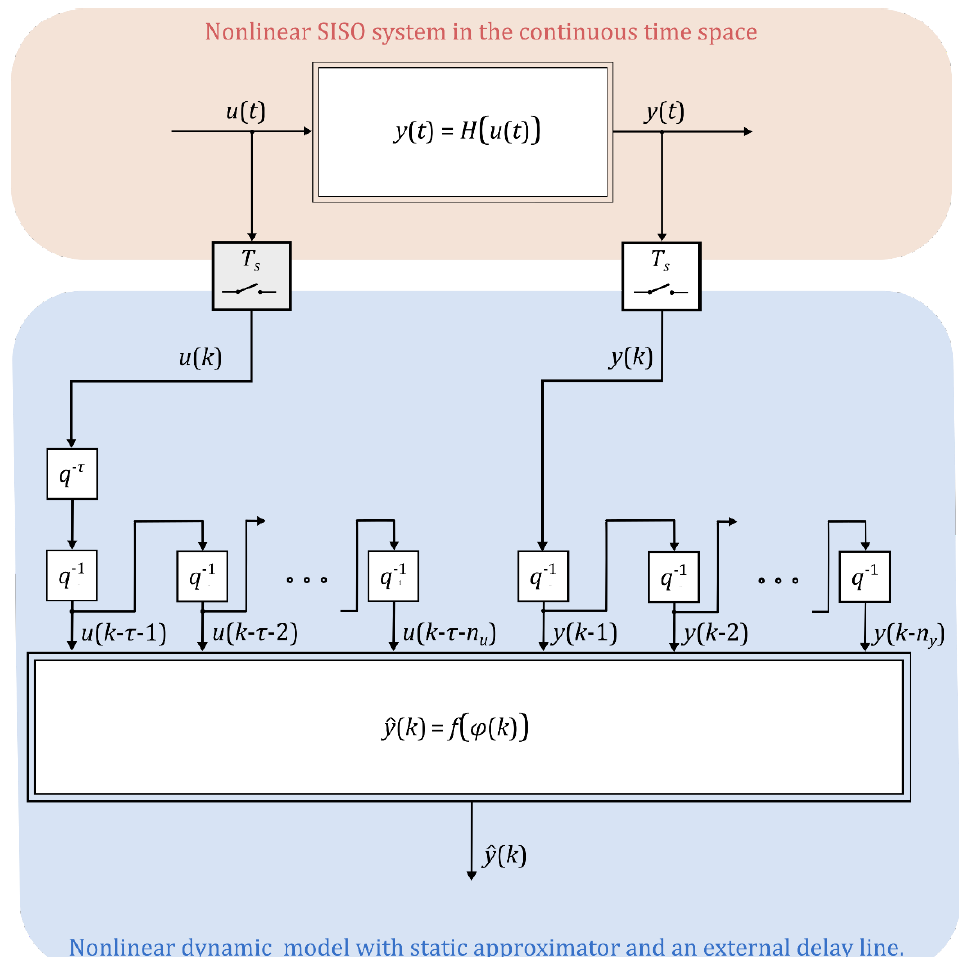
Figure 1. Nonlinear dynamic system modelling structure based on external dynamics strategy. Table 1. Structures of regression vectors for common input/output